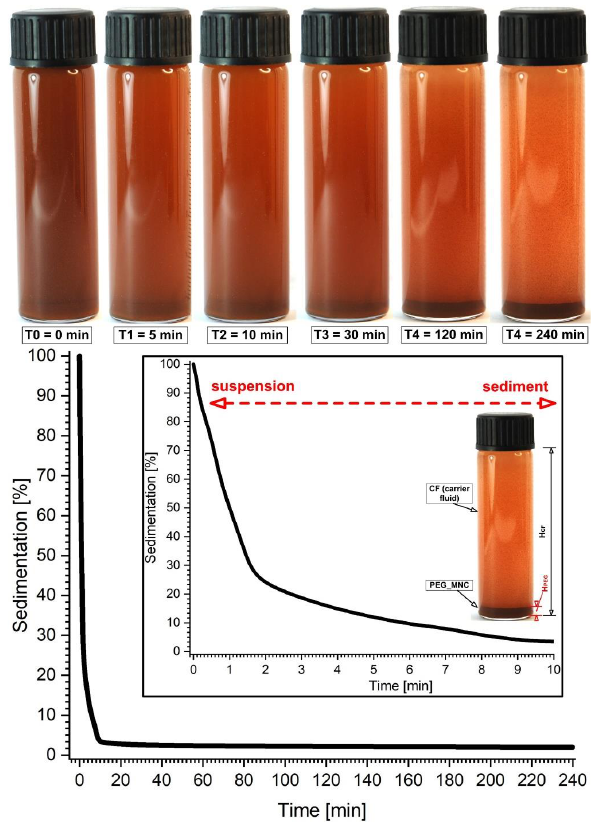
Figure 9. Sedimentation profile as a function of time for PEG_MNC suspension. Detail regarding sedimentation profile in the first 10 min. CF – carrier fluid; PEG_MNC-PEG-coated magnetic nanoclusters.